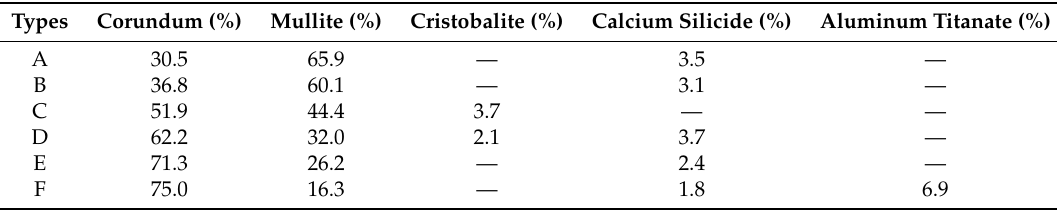
Figure 1. Types of calcined bauxite. ( A ) Bauxite-A; ( B ) Bauxite-B; ( C ) Bauxite-C; ( D ) Bauxite-D; ( E ) Bauxite-E; ( F ) Bauxite-F. The bauxite clinker with higher grade is denser and harder, while the bauxite clinker with lower grade has a looser surface, more fractured surfaces and larger pores. Table 1. Phase proportion of calcined